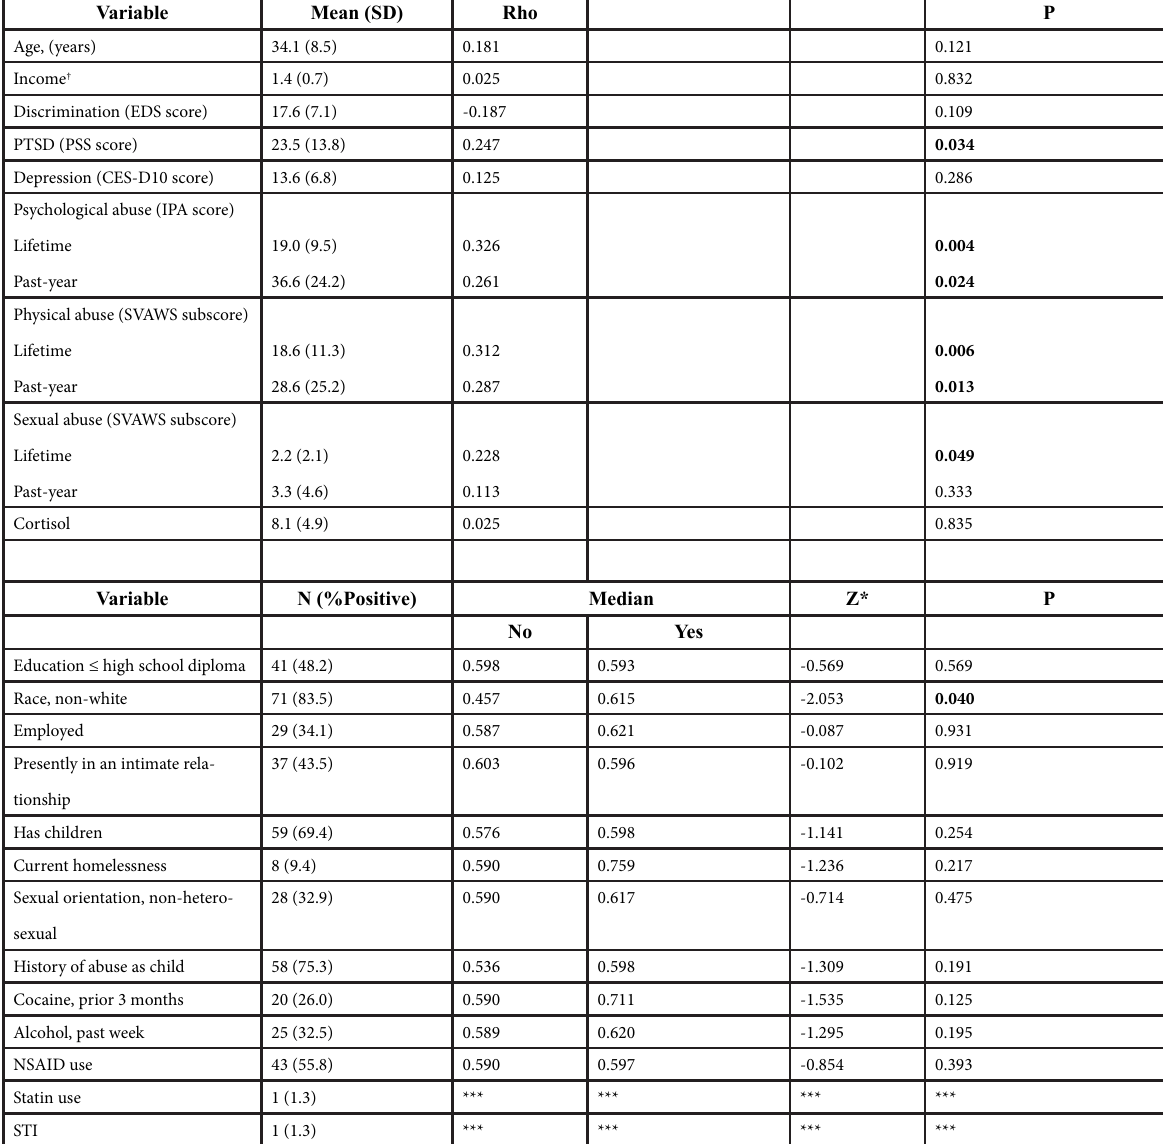
Table 1. Associations with CD4 activation (outcome) and demographic, behavioral, and clinical measures (predictors) in n = 75 subjects. SD = standard deviation; EDS = The Everyday Discrimination; PTSD = post-traumatic stress disorder; PSS = PTSD Symptom Scale; CES-D10 = 10-item Center for Epi- demiologic Studies of Depression Short Form; IPA = Index of Psychological Abuse; SVAWS=Severity of Violence Against Women Scale; NSAID=nonsteroidal anti-inflammatory drug; STI = sexually transmit- ted disease; † Income was measured as a 4-level variable where income < $10,000=1, $10,000 - 20,000 = 2, $20,000 - 40,000 = 3, and > $40,000 = Variable Mean (SD) Rho P Age, (years)